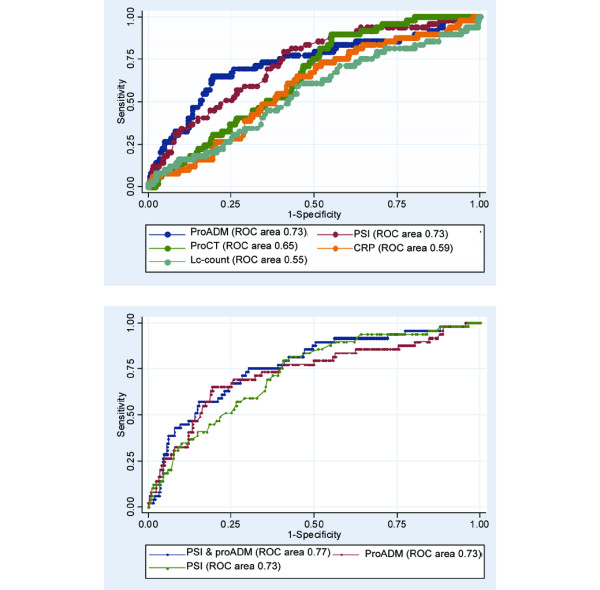
Receiver operator curve analysis of different laboratory parameters predicting failure after treatment of community-acquired pneumonia. Data on admission are shown. Upper panel: receiver operator curve (ROC) plot analysis of different parameters (i.e., pro-adrenomedullin (proADM), procalcitonin (proCT), C-reactive protein (CRP), leukocyte count (Lc count) and the pneumonia severity index (PSI)). Lower panel: ROC plot analysis of a combined model of proADM and the PSI compared to proADM and the PSI alone.